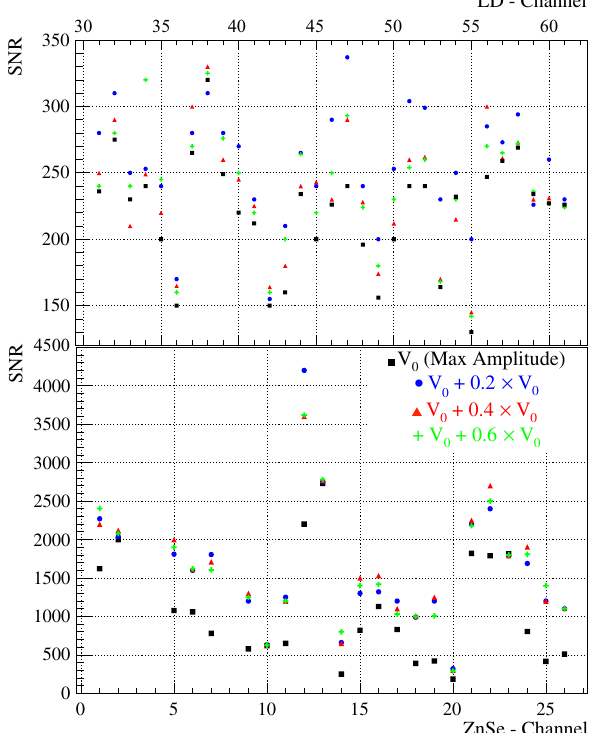
Fig. 24 Signal-to-noise ratio (SNR) scan for LDs (top) and ZnSe crys- tals (bottom) varying the voltage bias. It is calculated as the ratio of the filteredpulseramplitudetothe σ baseline .V 0 (MaxAmplitude)represents the biasing voltage which gives the maximal pulse amplitude. The scan is performed at bias higher than V 0 (Max Amplitude) because we expect a stronger reduction of the noise compared to the signal